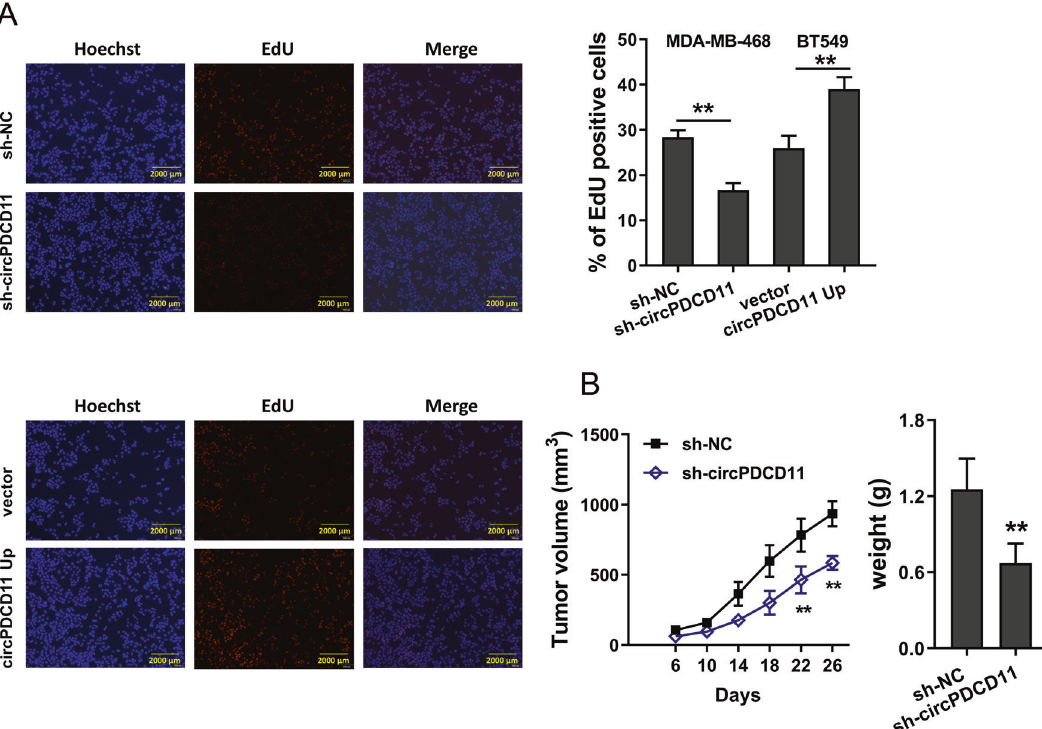
Fig. 3 circPDCD11 enhanced proliferation, and its silencing inhibited tumor growth in vivo. A An EdU assay was performed to detect the proliferative ability of TNBC cells (MDA-MB-468, BT549). B In vivo mouse xenograft experiments demonstrated the tumor growth of mice injected with circPDCD11-silenced TNBC cells (MDA-MB-468). The data are presented as the mean ± SD. Asterisks indicate signi fi cant differences (** p < 0.01).